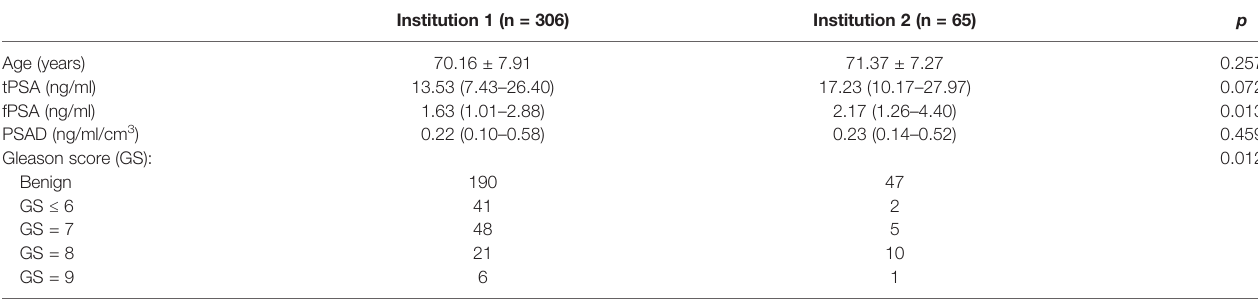
TABLE 1 | Characteristics of patients in the primary and external validation cohorts.